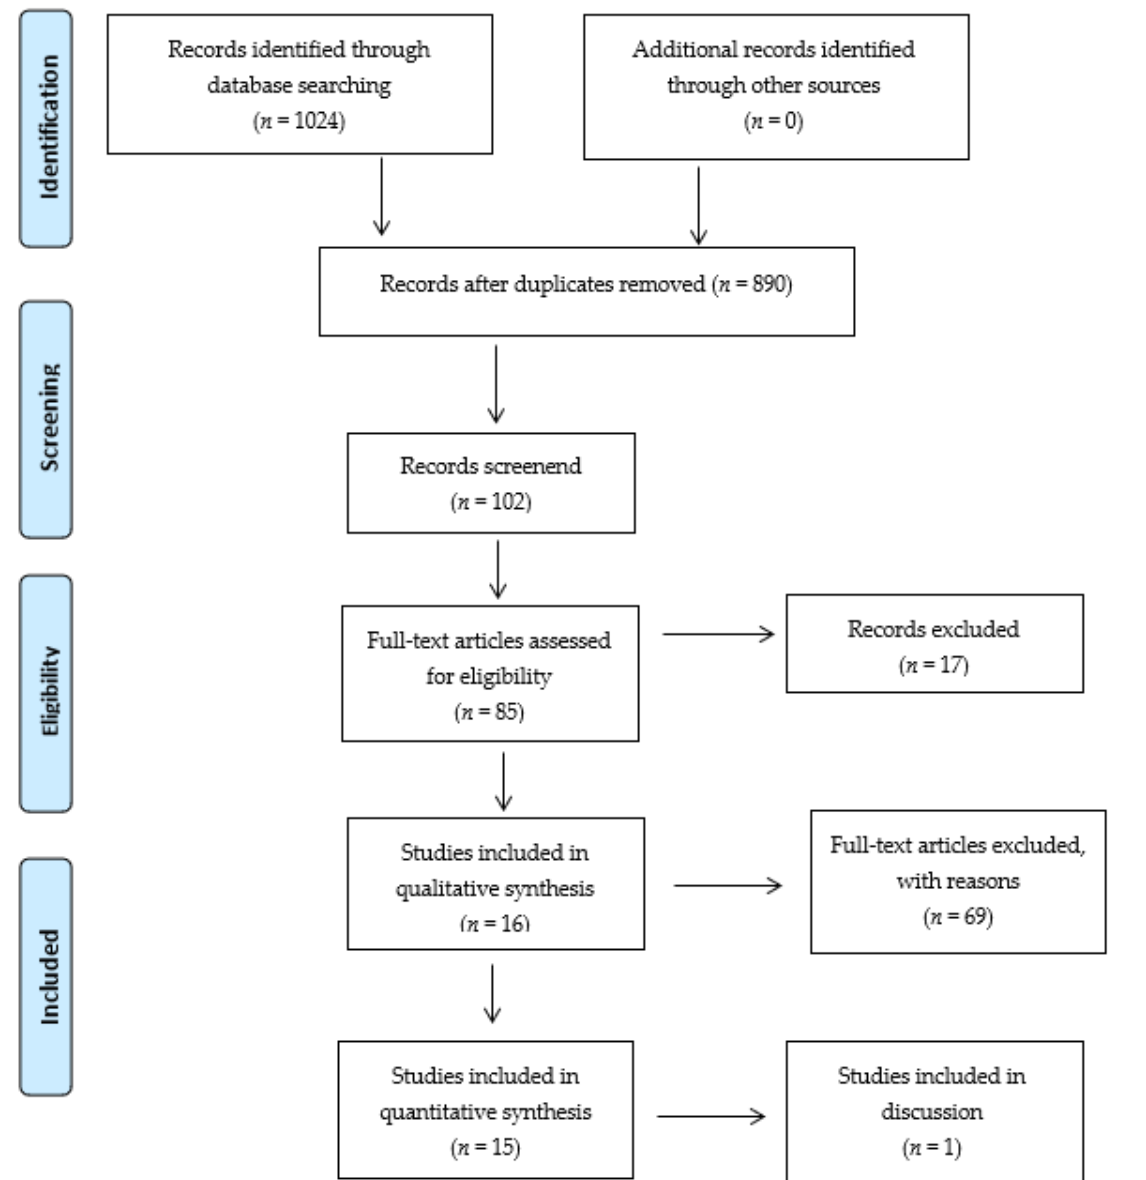
Figure 1. Preferred Reporting Items for Systematic Reviews and Meta-analyses (PRISMA) flow diagram of the study se- lection.